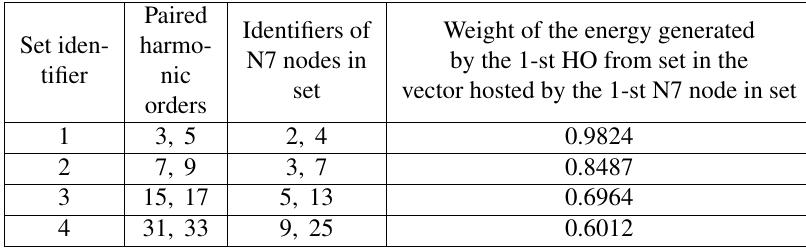
Table 1. Weights of the energies generated by 2 paired harmonics in the associated clustered of terminal nodes.